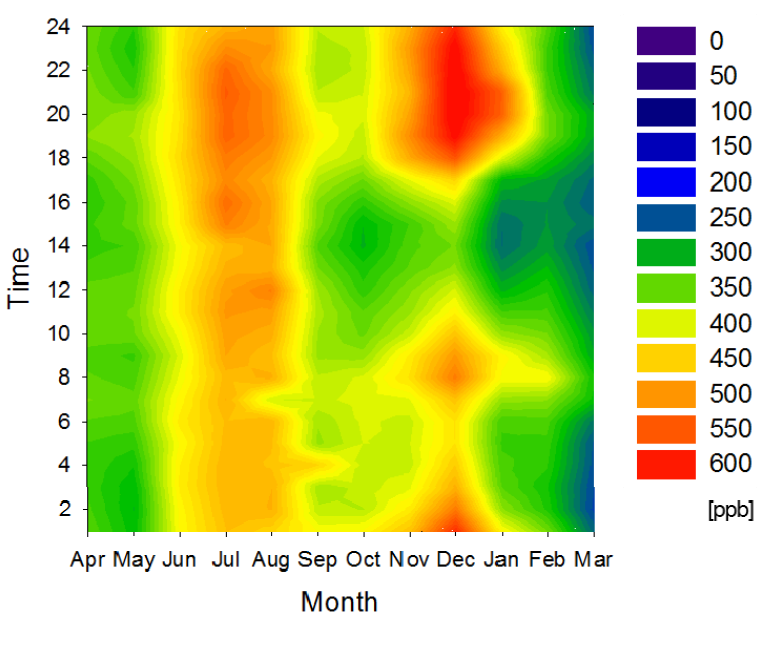
Figure 8. NMHC concentration contour map for cluster 5 in